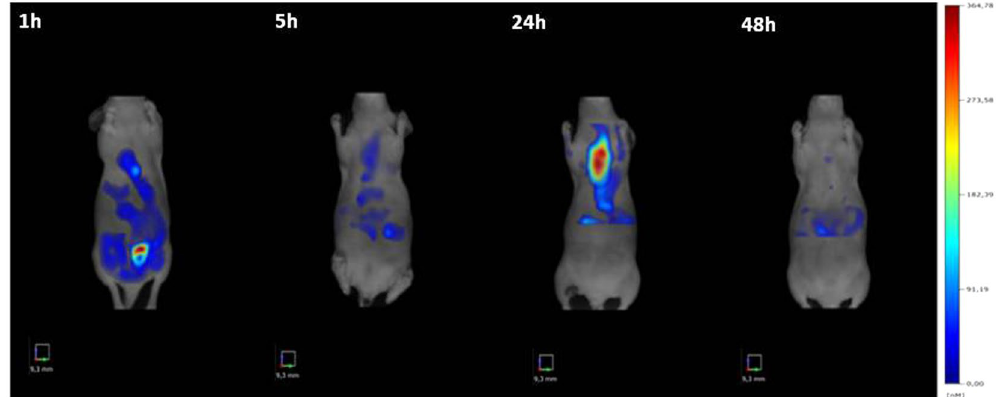
Figure 5. In vivo imaging of CXCR4 expressing human melanoma lung metastasis by PepR-NIR750. Mice bearing PES43-derived lung metastases were i . v . injected with Pep-R-NIR750 and imaged 3 weeks after